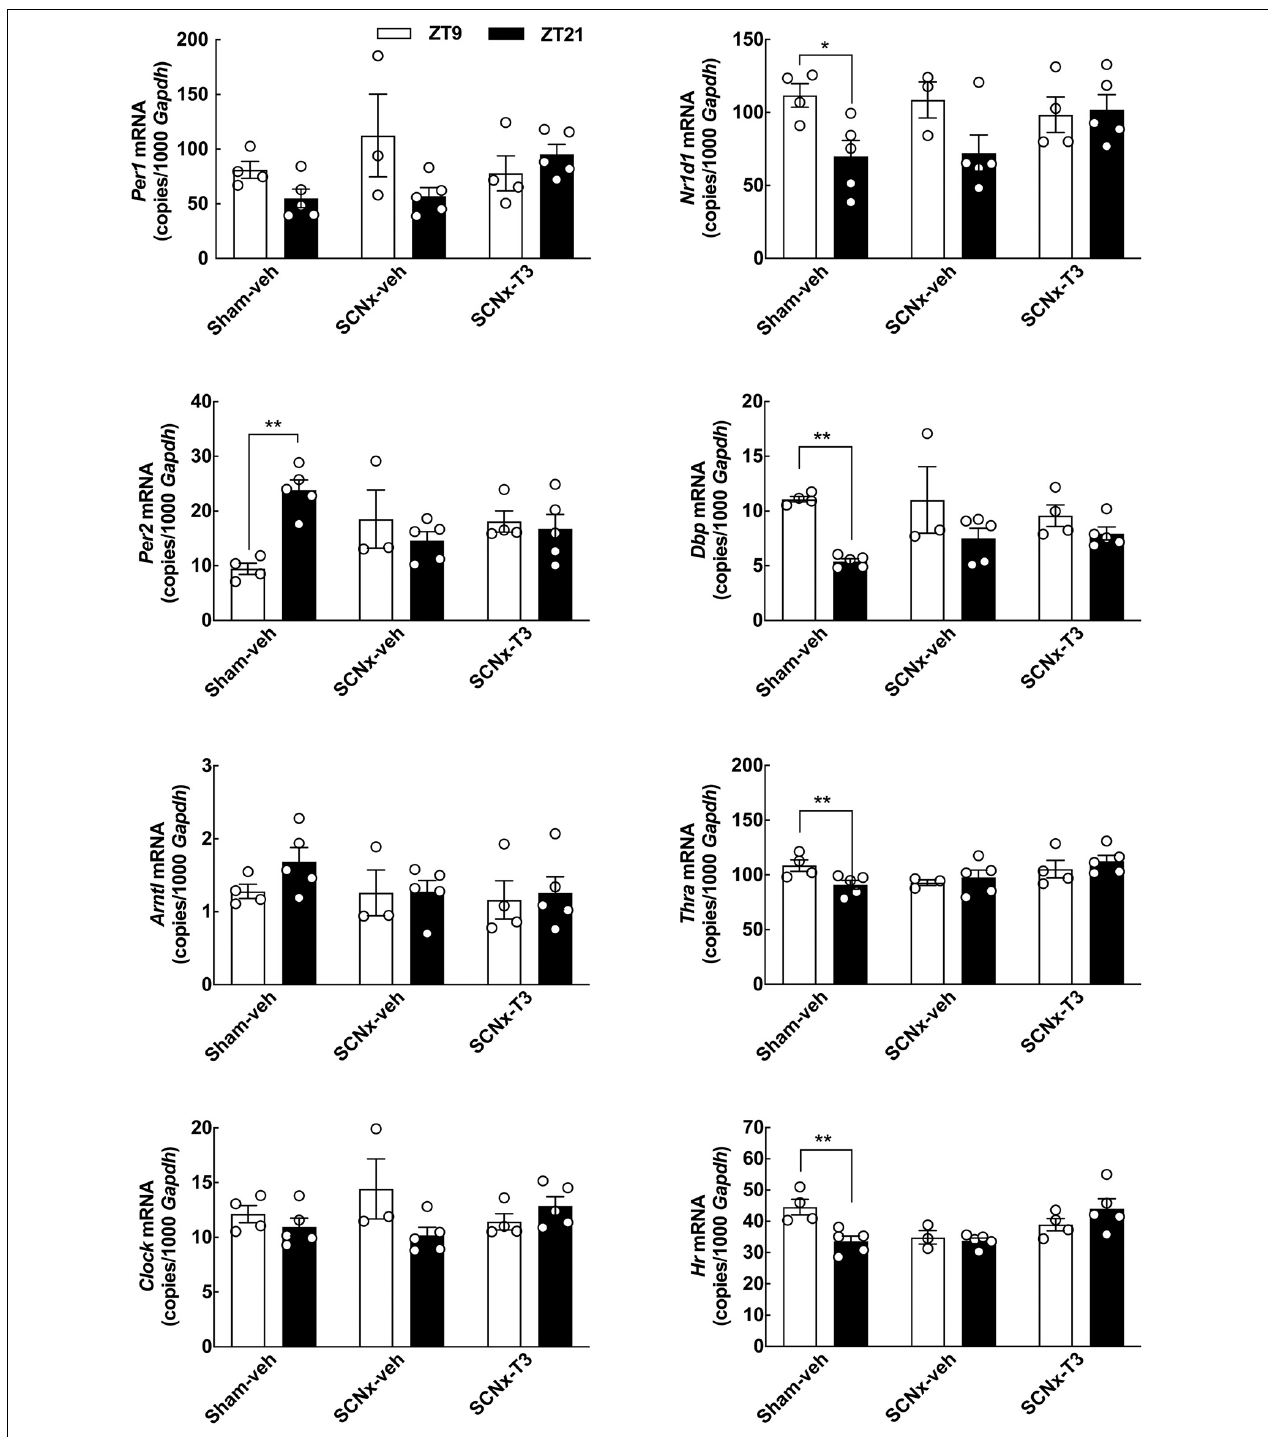
FIGURE 5 | Effects of circadian oscillating T3 concentrations on clock gene expression determined by qRT-PCR. Cerebellar expression of the clock genes Per1 , Per2 , Arntl, Clock , Nr1d1, and Dbp , as well as Thra and Hr , in three experimental groups of adult rats (8 weeks of age), Sham-veh, SCNx-veh, and SCNx-T3, at ZT9, and ZT21, respectively. Quantitative data were analyzed by two-way ANOVA followed by Bonferroni multiple-comparisons tests. Day-night differences were detected in Sham-veh animals in case of the Per2 , Nr1d1 , Dbp , Thra, and Hr . Significance levels of Bonferroni multiple-comparisons tests are displayed. * p < 0.05; ** p < 0.01. n =